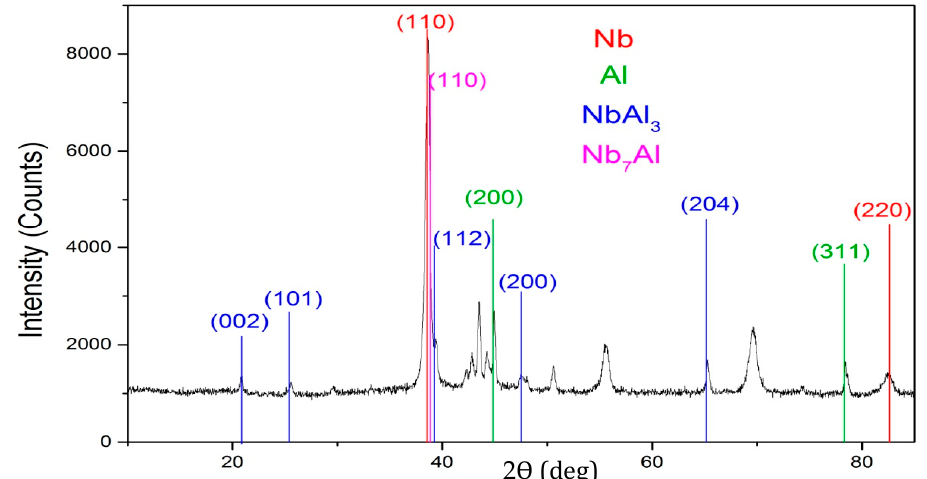
Figure 4. The X-ray diffraction for 2.52 km/s specimen.